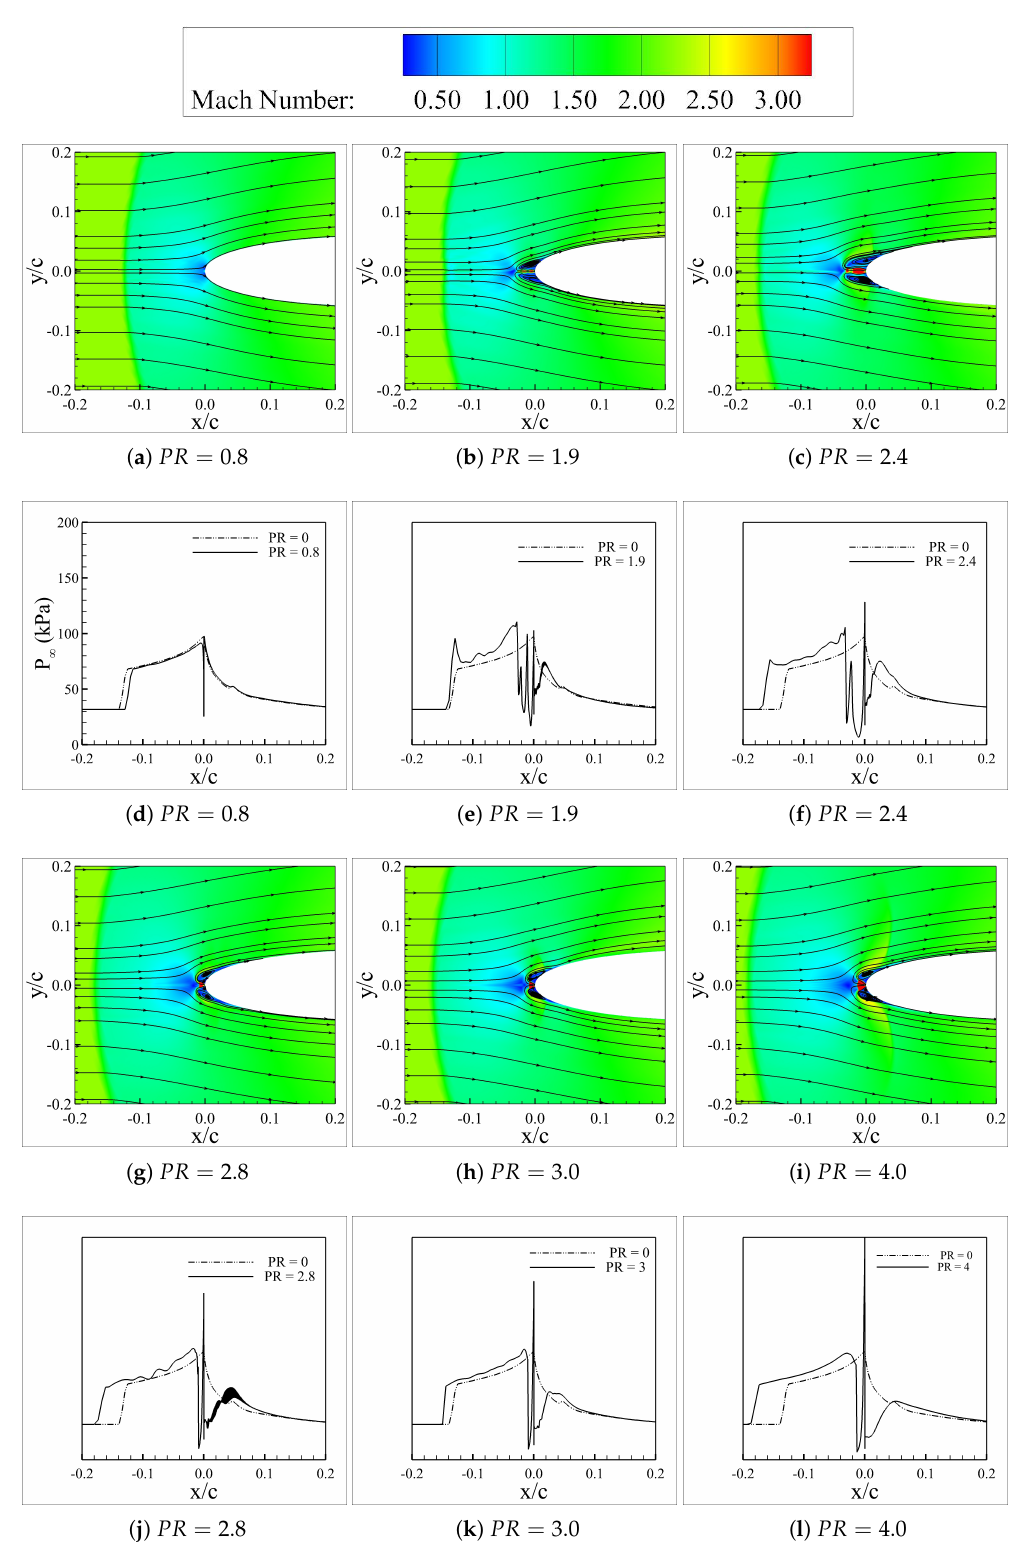
Figure 10. The pressure distribution of free stream flow at constant M ∞ = 1.4 and increasing PR between 0.8 to